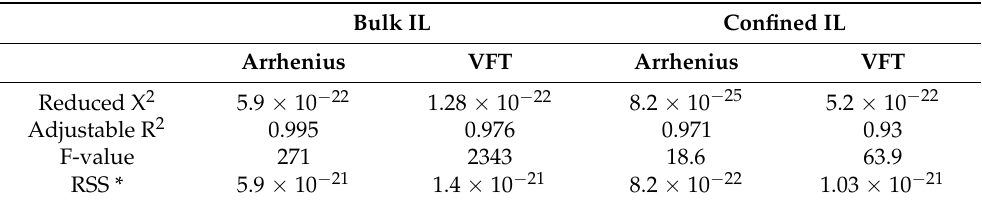
Figure A2. Replicate of the data shown in Figure 2 of the main text. Here, spin-relaxation times are shown versus reciprocal of temperature for both the bulk and confined ionic liquids. The lines are fit using the BPP model (refer to the main text for details). The two vertical dashed lines are the glass transition temperatures for the bulk ( Tg = 186.4 K) and confined ILs ( Tg = 190.5 K) obtained using the DSC technique (shown in Figure A1). The inset of the figure shows the spin-spin relaxation times T 2 vs T. Table A1. Statistical parameters obtained from fitting the self-diffusion data vs. 1000/T for the bulk and confined ILs using the Arrhenius and VFT models.